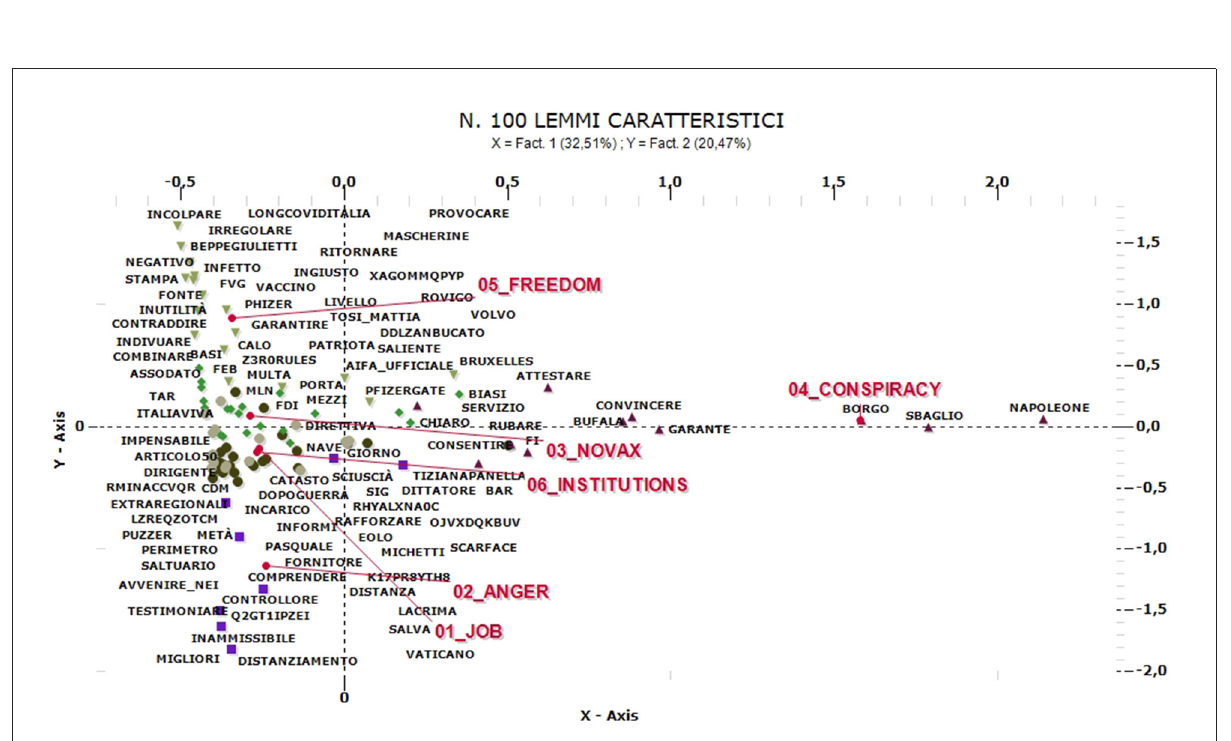
FIGURE13 ACM—“Greenpass” comments in Italian (100 characteristic